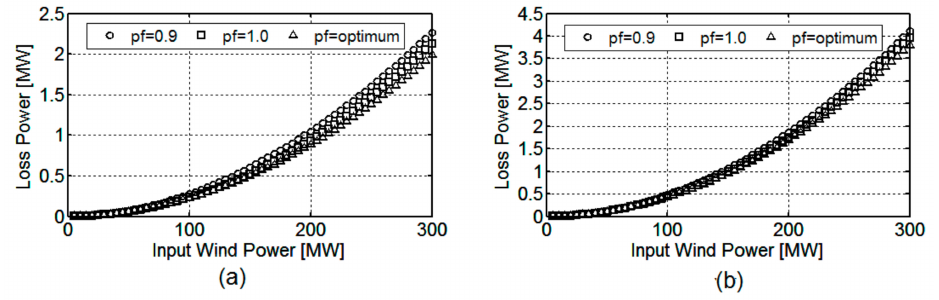
Figure 12. Power losses: ( a ) At the OWF; ( b ) at the